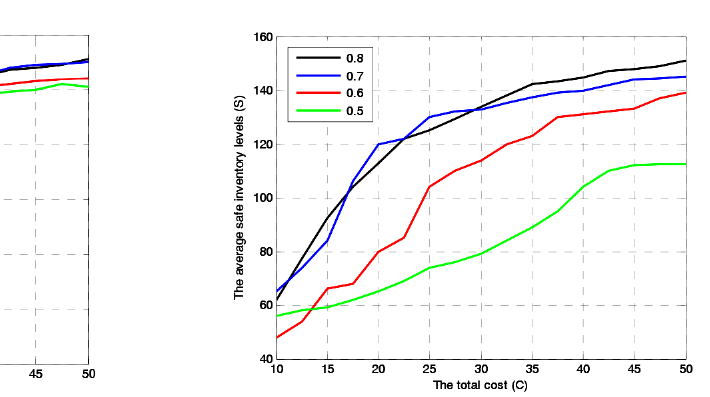
Figure 9. The sensitivity of α 2 Figure 10. The sensitivity of α 1